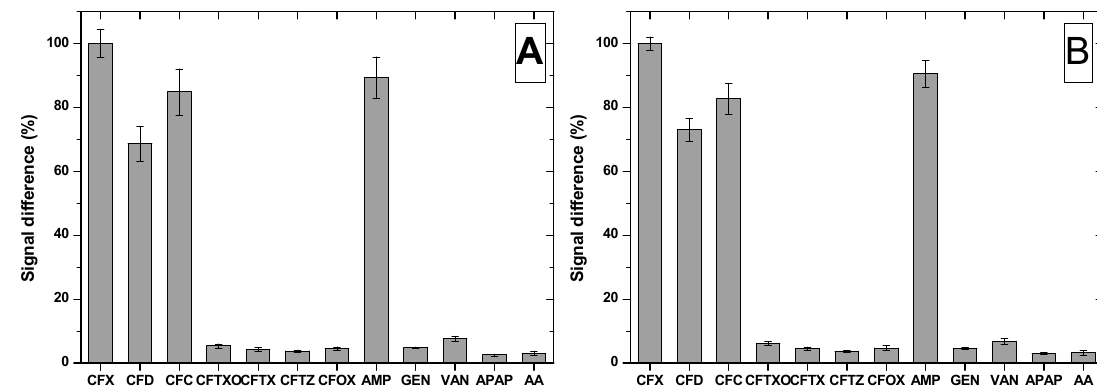
Figure 7. Selectivity tests using the MIP modified ( A ) BDDE and ( B ) GCE.